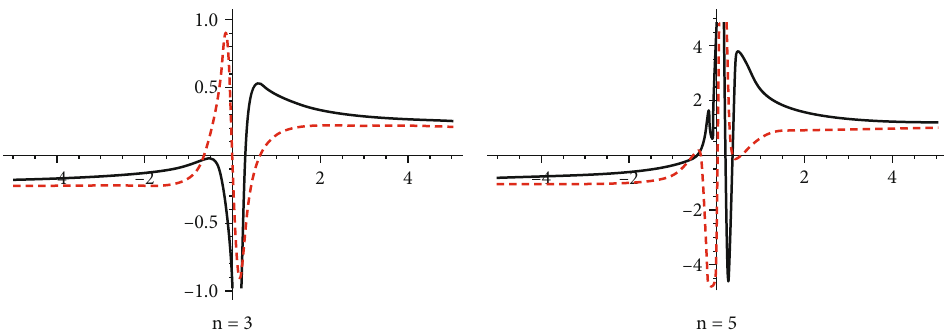
nz + 1 Þ for several values of n , whereas dashed lines represent the right-hand side of (23) with z ≡ x , n ð − 1 where α = 0 : 2